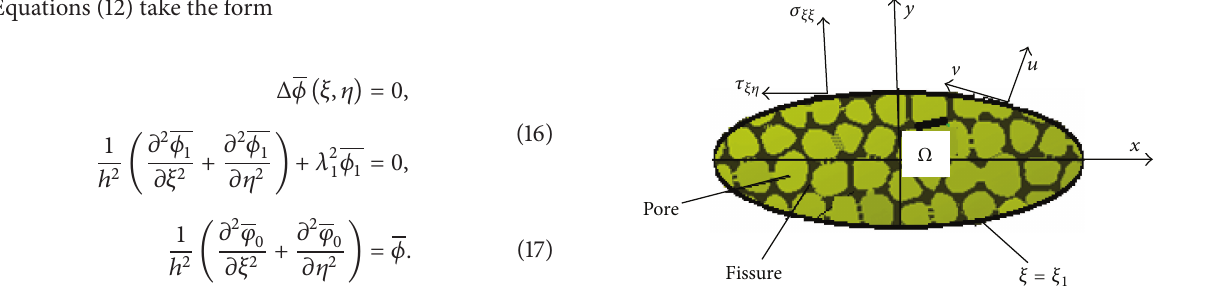
Figure 1: Ellipse with double